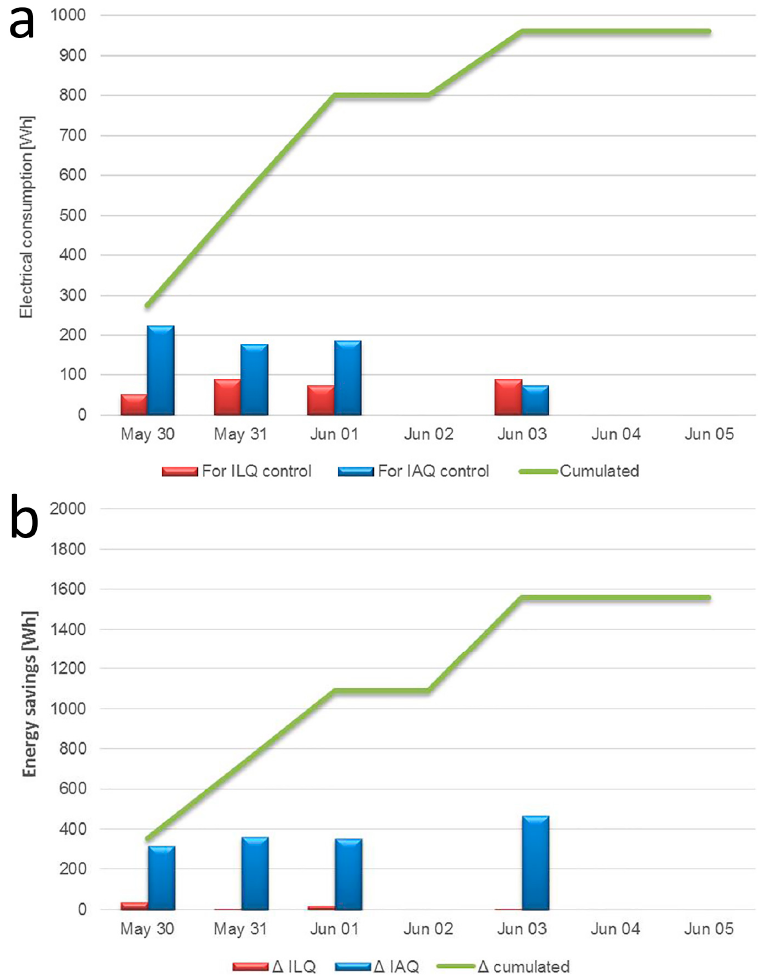
Figure 12. Analysis of consumptions: ( a ) electrical consumptions; ( b ) energy savings. ILQ: indoor lighting quality.